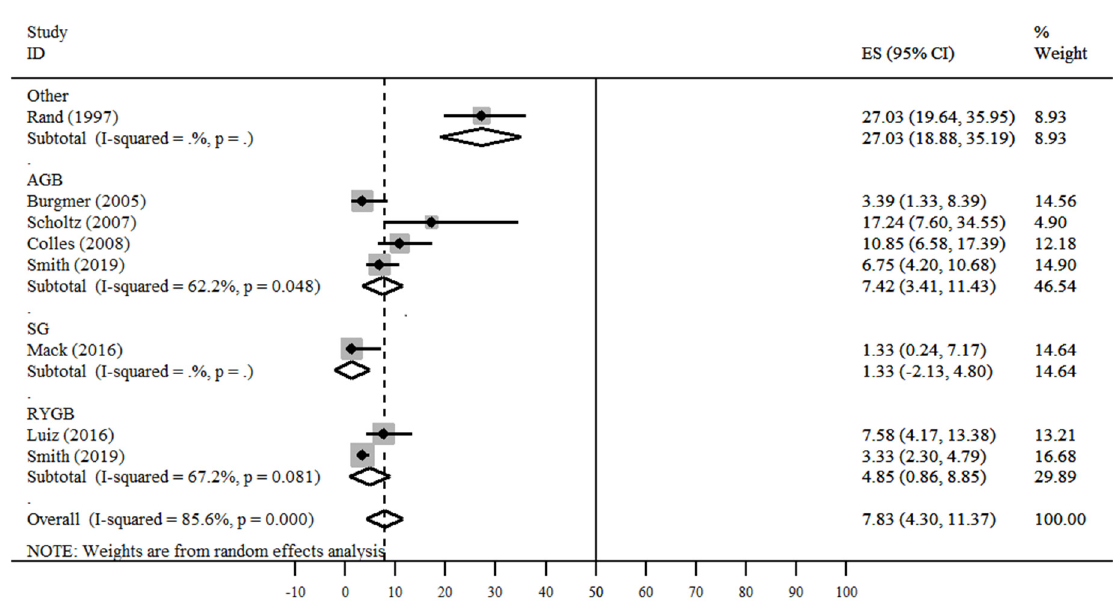
Figure 5. Prevalence of disorders in the postoperative period by type of surgery [13–26].